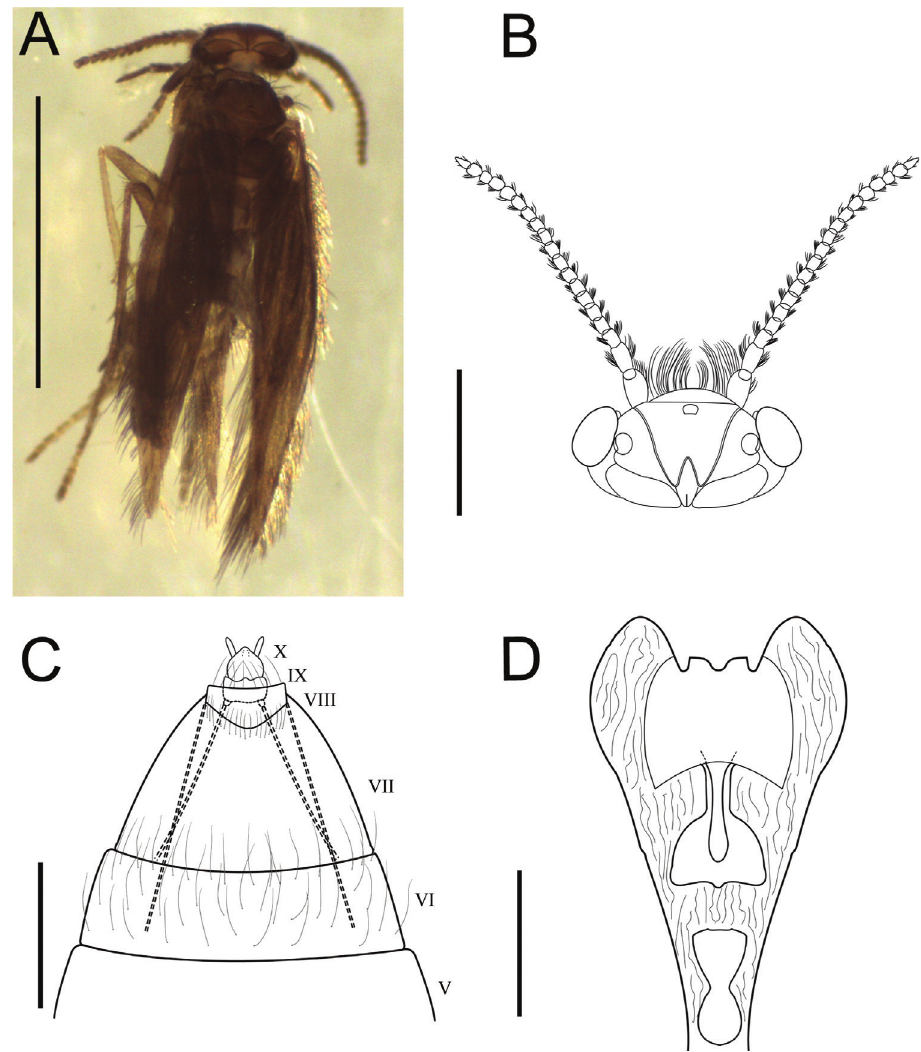
Figure 3. Female specimen of Mejicanotrichia harrisi Bueno-Soria & Barba-Álvarez, 1999 A habitus, dorsal B head, dorsal C segments VI-X of abdomen, ventral D bursa copulatrix ventral. Scale bars: 1 mm ( A ); 800 µm ( B ); 200 µm ( C ); 30 µm ( D